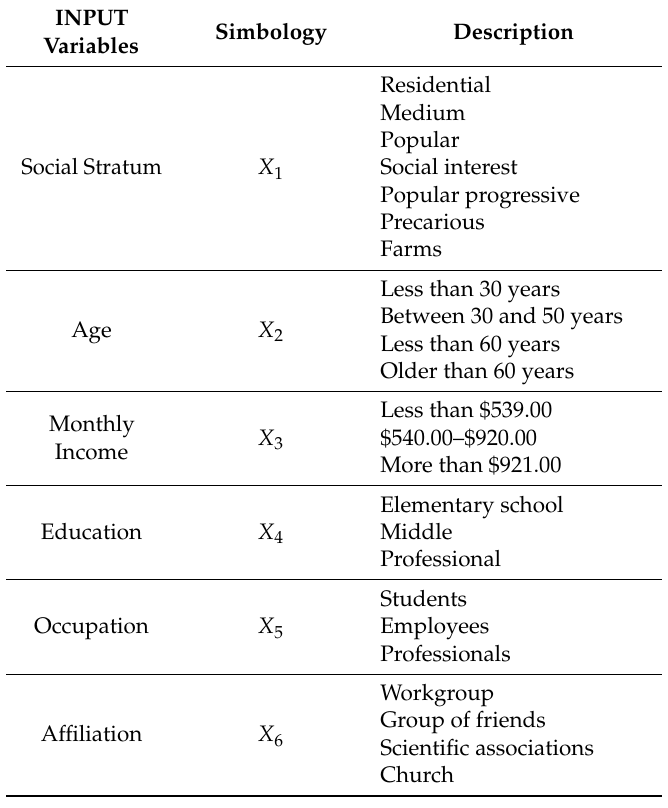
Table 2. Socio-demographic profiles associated with the development of 3Rs (INPUTS).